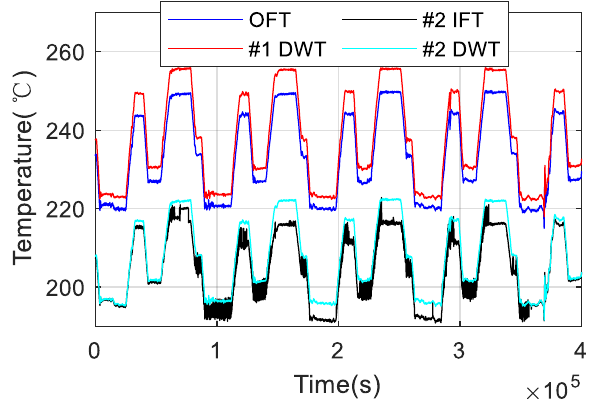
Figure 7. The water temperature duration curve.